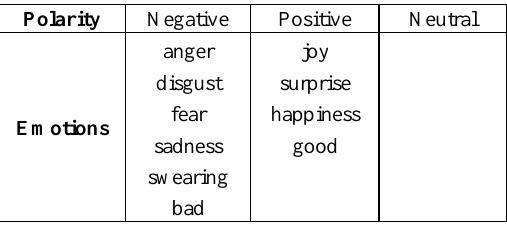
Table 3 . Polarity and emotions that Gate Cloud Service “DecarboNet Environmental Annotator” extracted from 52 online articles, concerning climate